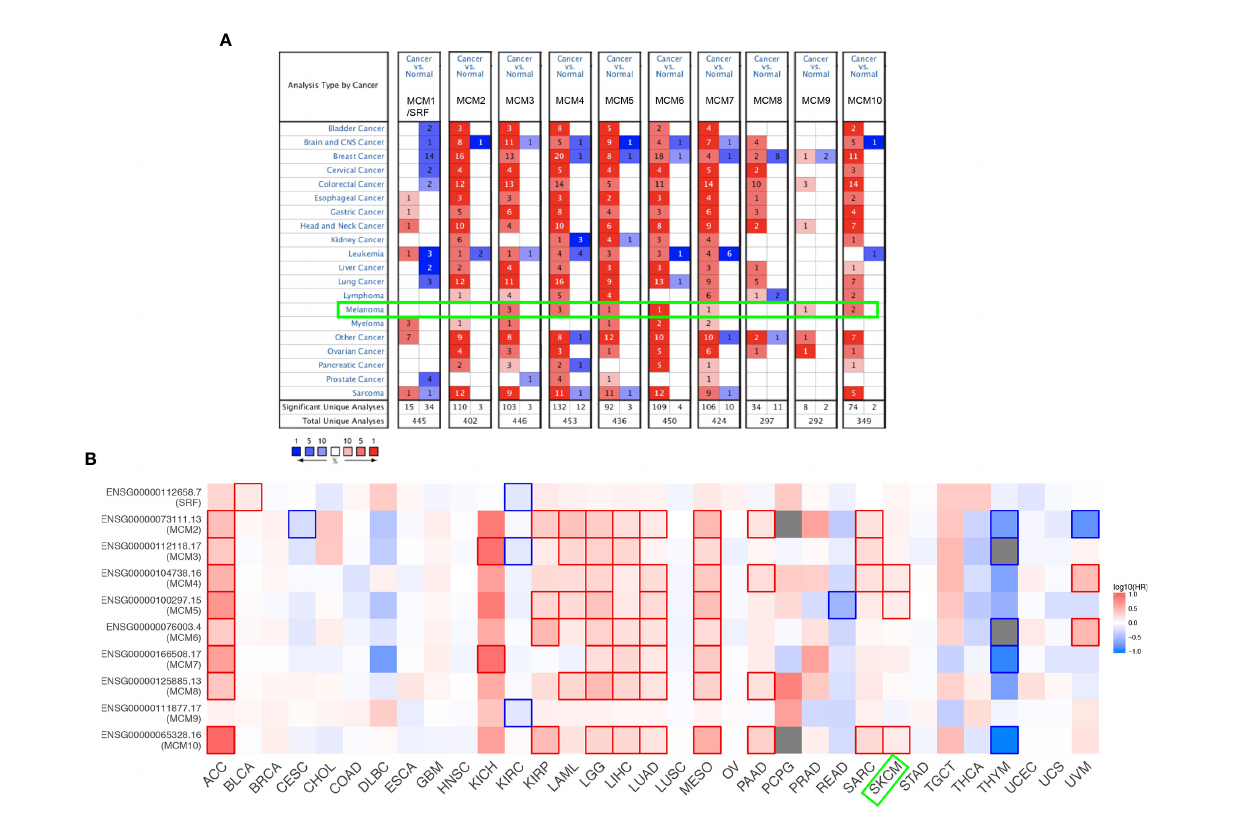
FIGURE 1 | Expression level andsurvival analysis of MCM s byONCOMINE andGEPIA. (A) The fi gure shows thenumbersofdatasets with statistically signi fi cant mRNA overexpression(red)ordownregulatedexpression(blue)of MCM s. (B) Summary of hazardratios(HR) illustrating cancer- MCM pairs with alteredprognosis. ACC, Adrenocortical Carcinoma; BLCA,BladderUrothelial Carcinoma; BRCA, Breast Invasive Carcinoma; CESC, CervicalSquamous CellCarcinoma andEndocervicalAdenocarcinoma; CHOL, Cholangiocarcinoma; COAD, ColonAdenocarcinoma; DLBC, LymphoidNeoplasm Diffuse Large B-cell Lymphoma; ESCA, EsophagealCarcinoma; HNSC, HeadandNeck Squamous Cell Carcinoma; KICH, Kidney Chromophobe; KIRC,Kidney RenalClear CellCarcinoma; KIRP, Kidney RenalPapillary Cell Carcinoma; LAML, Acute Myeloid Leukemia; LGG, Brain Lower GradeGlioma; LIHC, Liver Hepatocellular Carcinoma; LUAD, Lung Adenocarcinoma; LUSC, Lung Squamous Cell Carcinoma; MESO, Mesothelioma;OV, Ovarian Serous Cystadenocarcinoma; PAAD,Pancreatic Adenocarcinoma; PCPG, Pheochromocytomaand Paraganglioma;PRAD, Prostate Adenocarcinoma; READ, Rectum Adenocarcinoma; SARC, Sarcoma; SKCM, SkinCutaneous Melanoma; STAD, StomachAdenocarcinoma; TGCT, Testicular GermCell Tumors; THCA, Thyroidcarcinoma; THYM, Thymoma; UCEC, UterineCorpusEndometrial Carcinoma; UCS, UterineCarcinosarcoma; UVM,